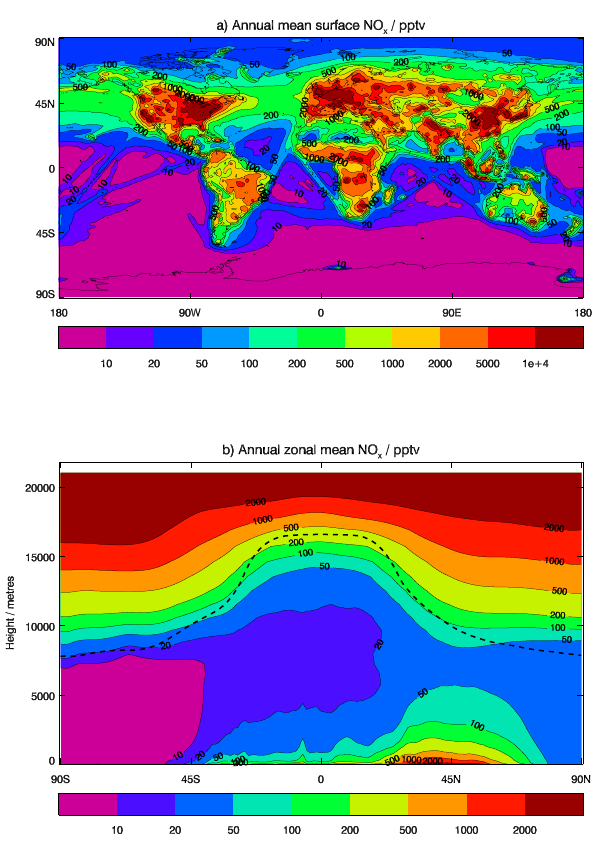
Fig. 18. Multi-annual (a) surface and (b) zonal mean NO x distributions from the StdTrop chemistry scheme in the tropospheric configuration of the UKCA model. The thick dashed line in (b) marks the position of the modelledtropopause(Hoerlingetal.,1993).